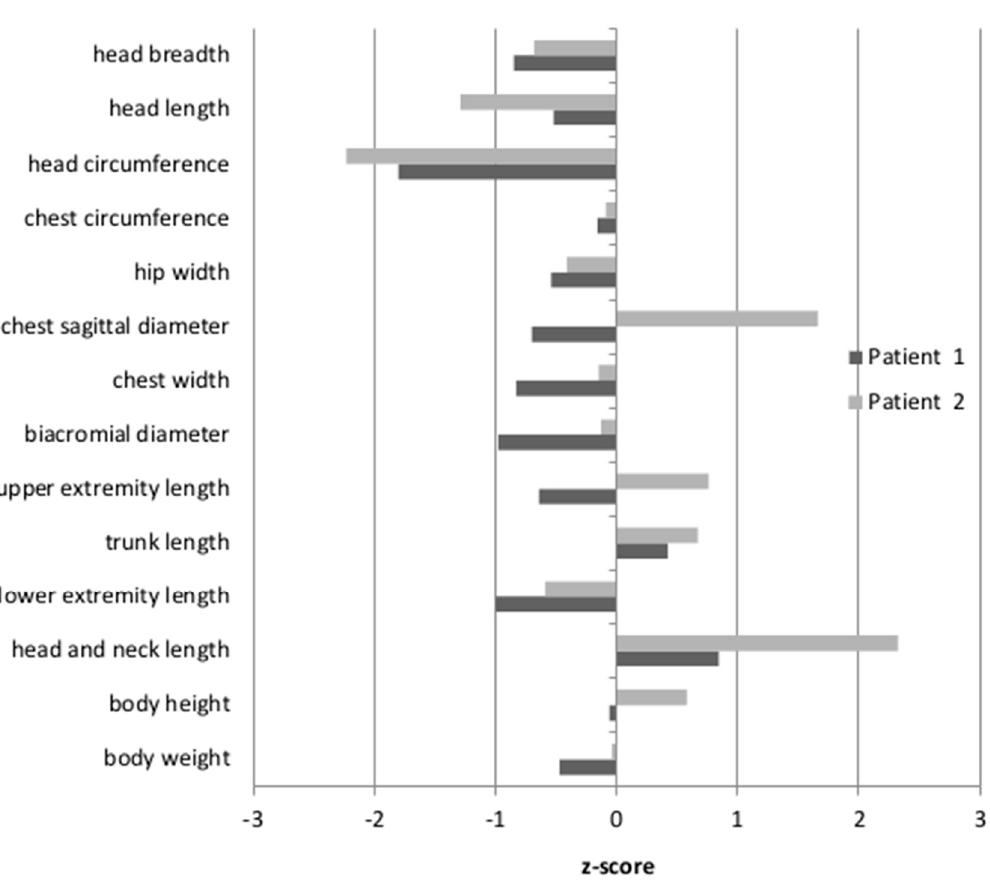
Figure 1. Z-scores for Patients 1 and 2. The results of anthropometric measurements were standard- ized, based on the mean and the standard deviation of the examined feature in a given age group of the healthy Polish children. Table 1. Isoelectric focusing (IEF) of transferrin in our patients with ALG13 c.320A>G variant (CDT values exceeding the reference range are marked with red). The letter below the patient’s number corresponds to the band showed in Figure